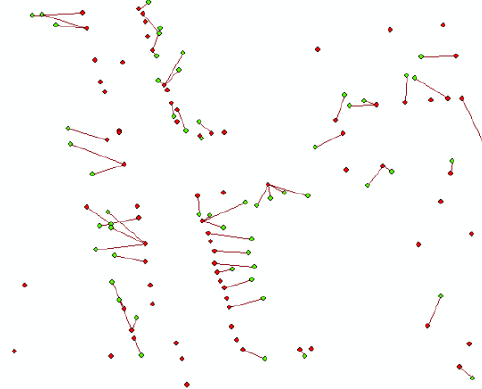
Figure 5 . Fuzzy Consistency Matching Results(partly)